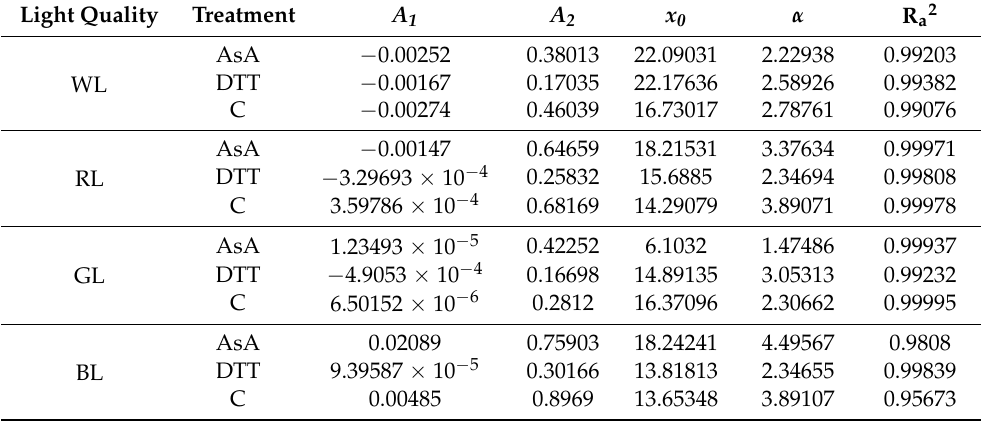
of the inflection point, α —a slope of the logistic growth rate (steepness of the curve), R a2 —the adjusted r-square value, determining the goodness of fit, accounts for the degrees of